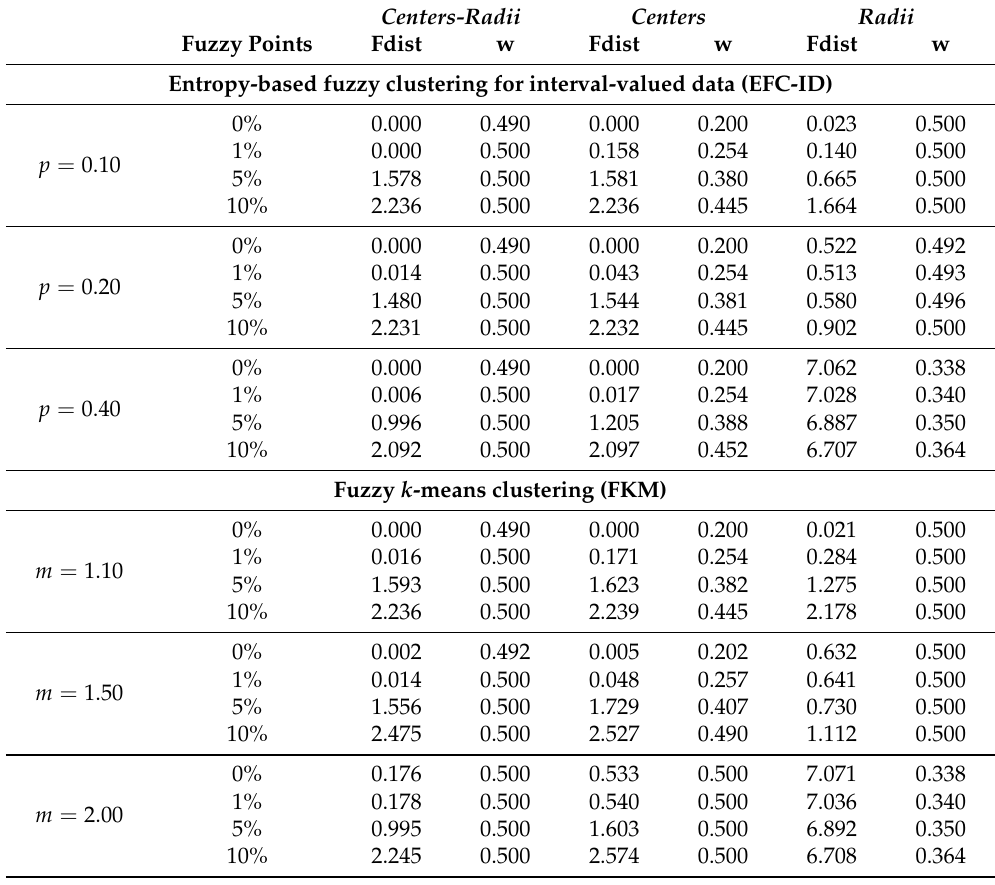
Table 3. Clustering models performance with well-separated clusters (0% of fuzzy points) and not well-separated clusters (1%, 5%, 10% of fuzzy points). Centers-Radii Centers Radii Fuzzy Points Fdist w Fdist w Fdist w Entropy-based fuzzy clustering for interval-valued data (EFC-ID)